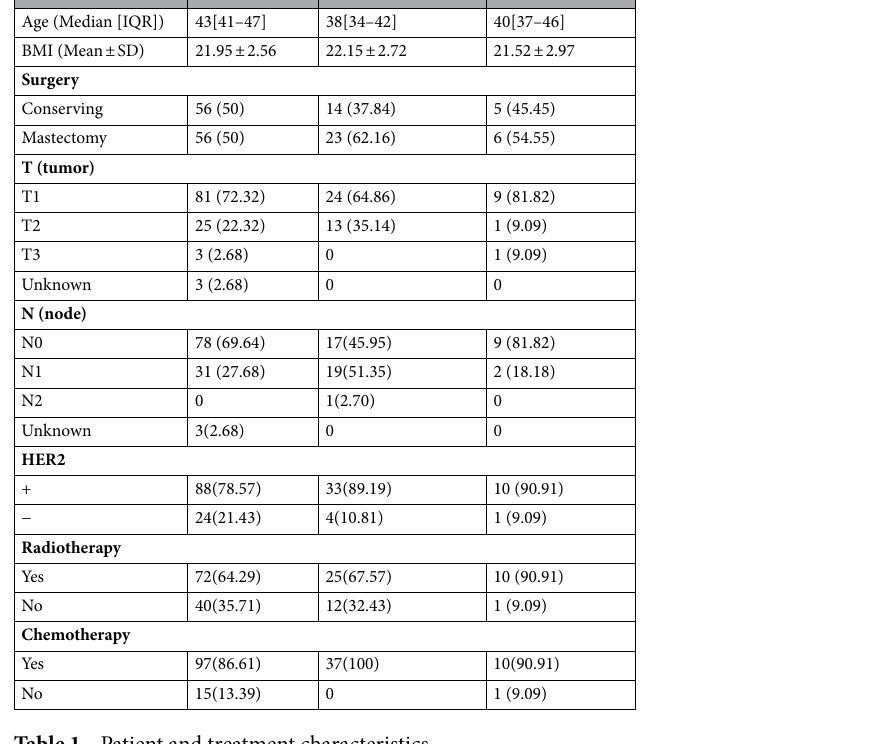
Table 1. Patient and treatment